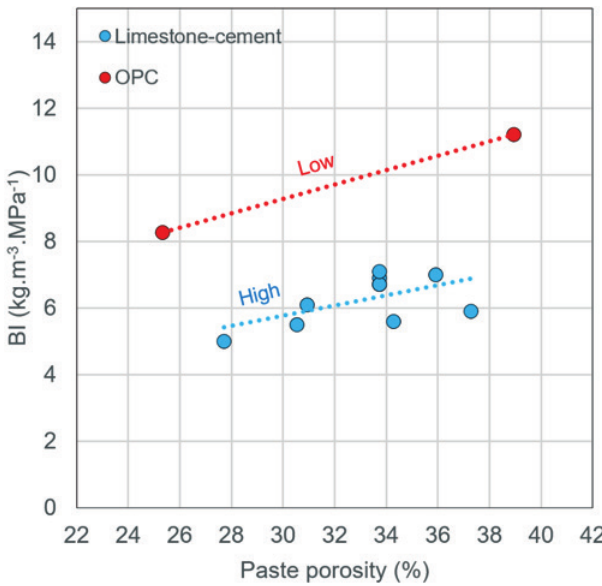
Figure 9 Benchmark of the binder use efficiency found in the national literature (green) and international (red) [24]. The concrete measured in this study appears in grey (packing control particles) and black (conventional Brazilian design